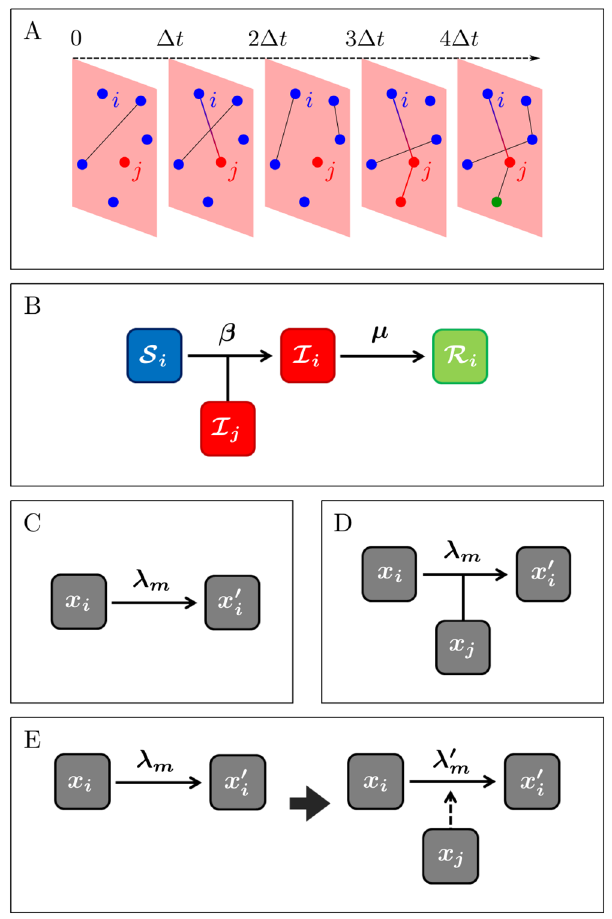
Fig 1. Schematic representation of a compartmental contagion process on a network. (A) Illustration of a contagion process evolving on a time-varying network. Nodes ’ colors correspond to their current state; edges denote current contacts between nodes; edge colors correspond to: black: no contagion may take place over the edge, red: contagion takes place during the present time-step, and red-to-blue gradient: contagion is possible but does not take place. (B) Example: reaction types in the SIR model. (C) Spontaneous reaction: a node i may spontaneously transition from its current state x i to x 0 i with rate λ m . (D) Contact-dependent reaction: a node i may transition from its current state x i to x 0 i with rate λ m upon contact with the node j in state x j . (E) Mixed transition: a node i may spontaneously transition from its current state x i to another state, x 0 i with rate λ m ; contact with another node j , in state x j , may alter the transition rate of m